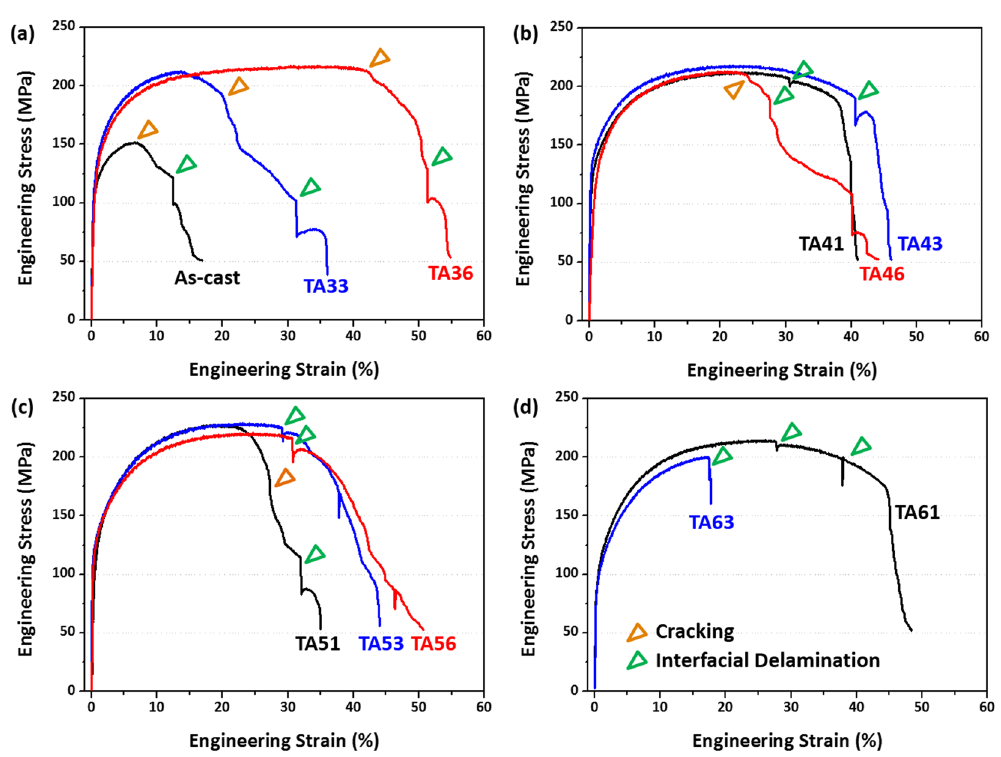
Figure 4. Room-temperature engineering stress-strain curves. Tensile stress-strain curves of the ( a ) as-cast and 350 °C-annealed, ( b ) 400 °C-annealed, ( c ) 500 °C-annealed, and ( d ) 600 °C-annealed specimens. Strains at the cracking point and interfacial delamination point are indicated by brown and green arrows,